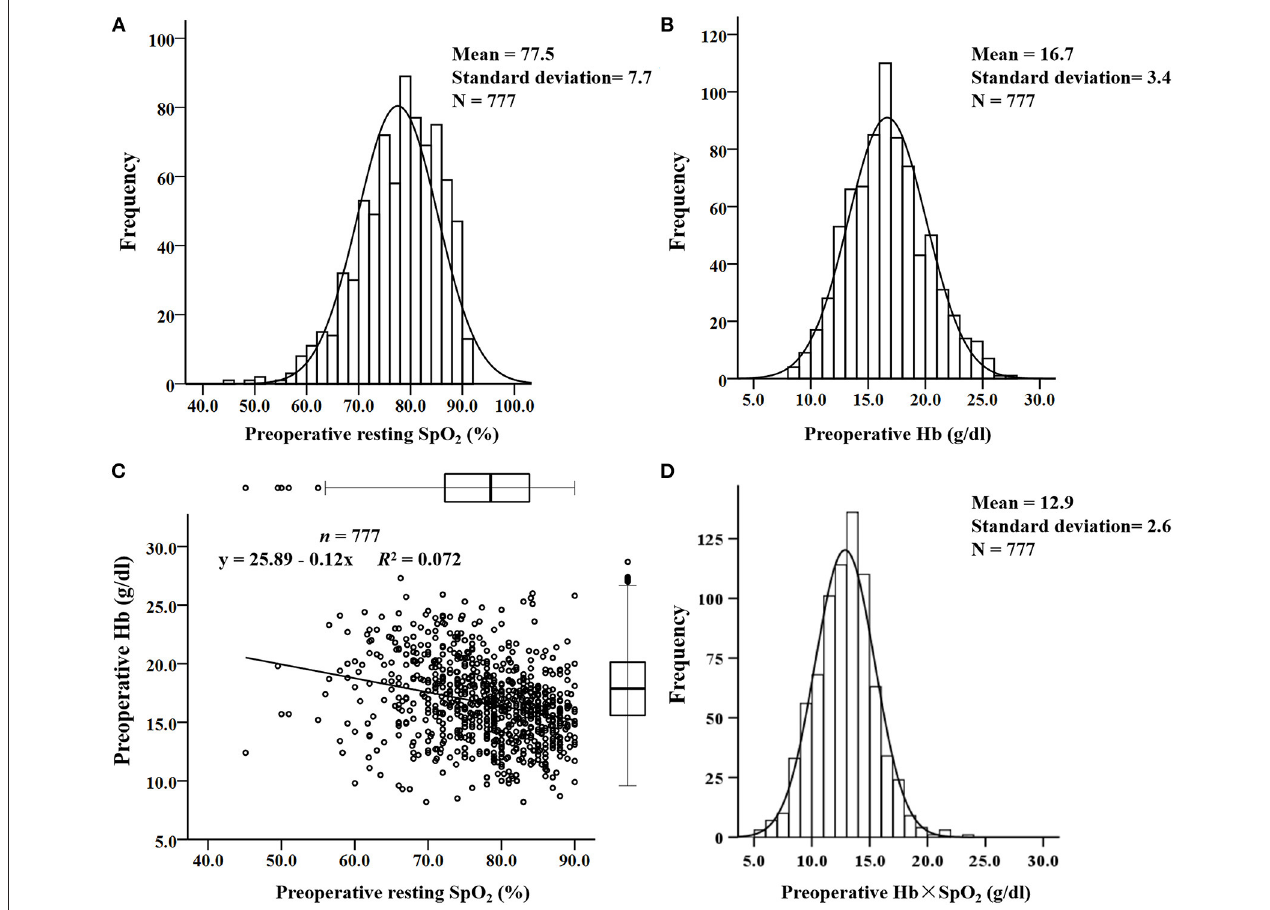
FIGURE 1 | The distribution and linear relationship of resting pulse oxygen saturation (SpO 2 ) and preoperative hemoglobin (Hb) concentration in cyanotic children. (A) Distribution of resting SpO 2 ; (B) distribution of preoperative Hb concentration; (C) linear relationship between preoperative Hb concentration and resting SpO 2 ; (D) distribution of the preoperative Hb × SpO 2